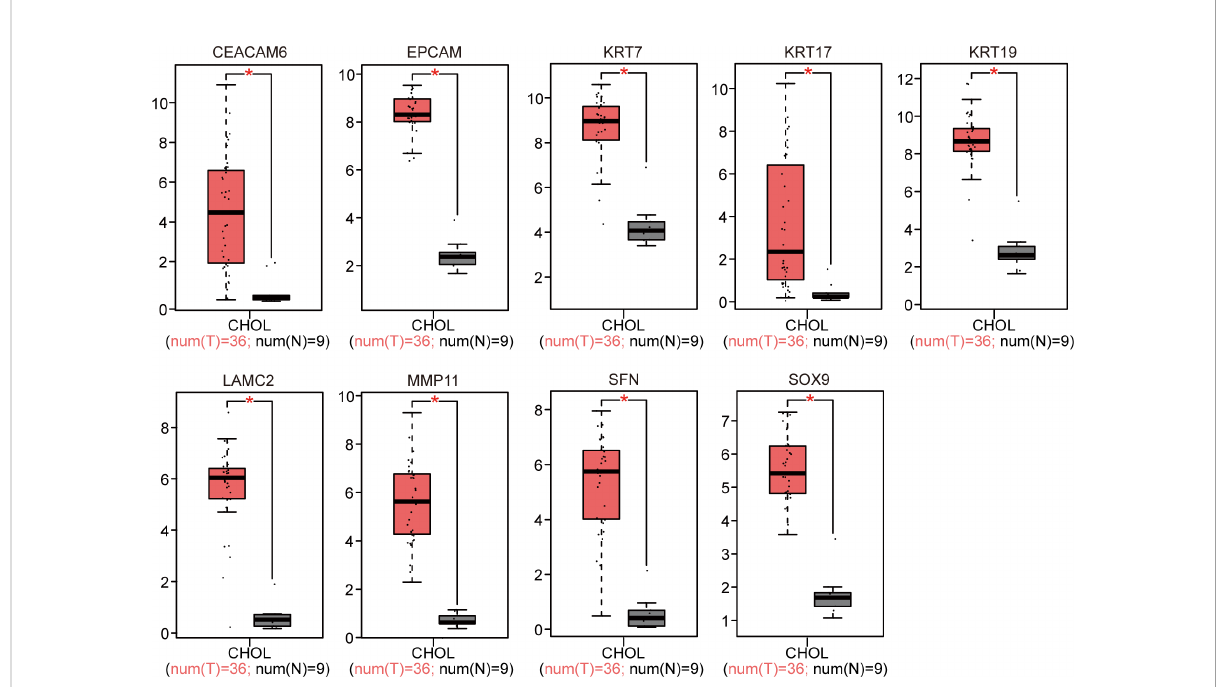
FIGURE 4 GEPIA website-based veri fi cation of the expression of nine upregulated genes associated with poor prognosis (*P < 0.05).